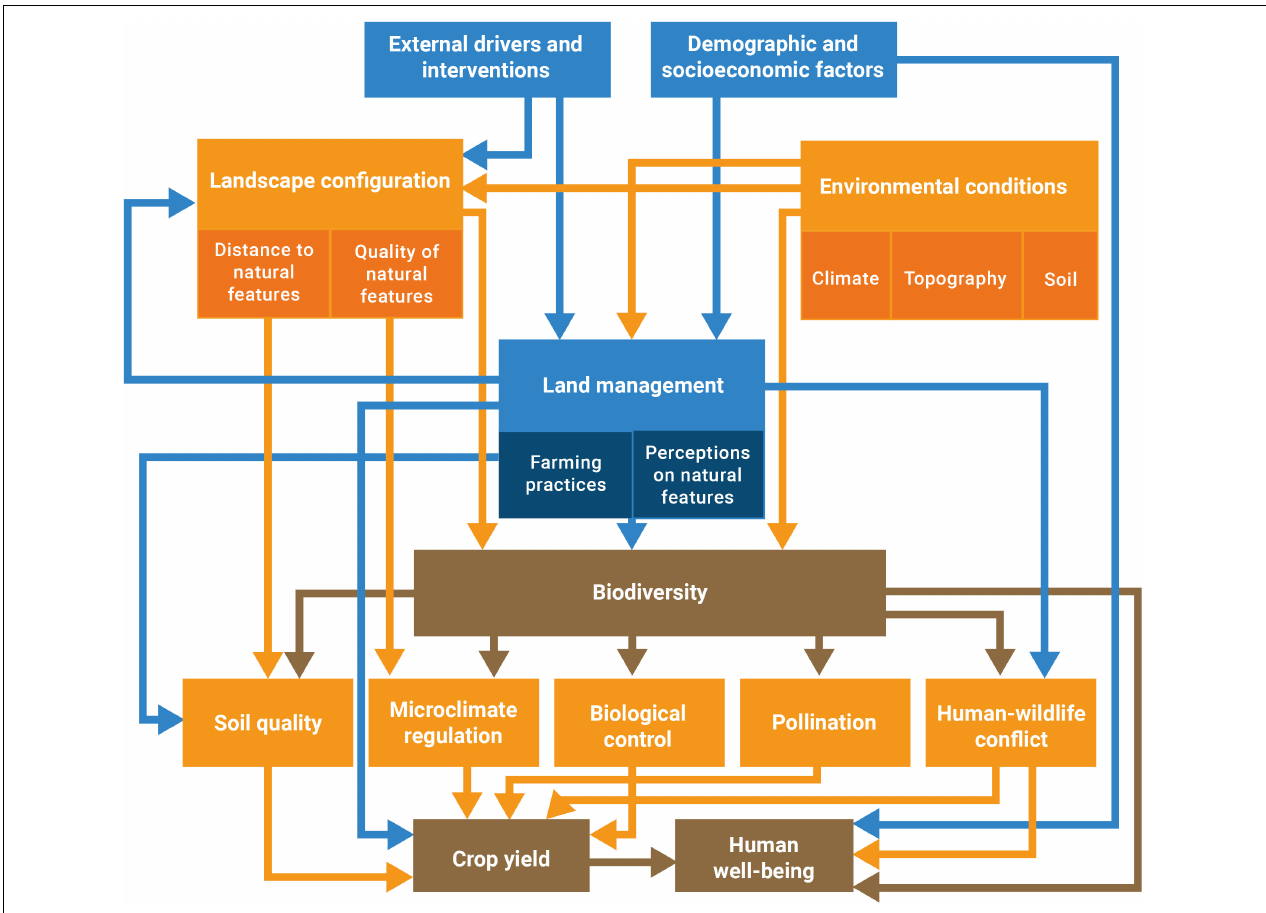
FIGURE 2 | System model approach operationalising the assessment of management of forest-agricultural landscapes for multiple objectives. The model describes a network of relationships among variables and processes important to understanding socio-ecological systems within forest-agricultural landscapes. Arrows represent causal links between variables at landscape and site scale to be tested. Pollination, biological pest control, microclimate regulation, maintenance of soil quality are ecosystem services, while crop yield is an ecosystem service too that is impacted by the other services and a key outcome of our framework. Human-wildlife conflict is an ecosystem disservice. Blue colour refers to components linked to the social dimension, orange components link to the ecological dimension, brown objects refer to outcomes directly linked to nature conservation, food security, and human well-being, within the socioecological